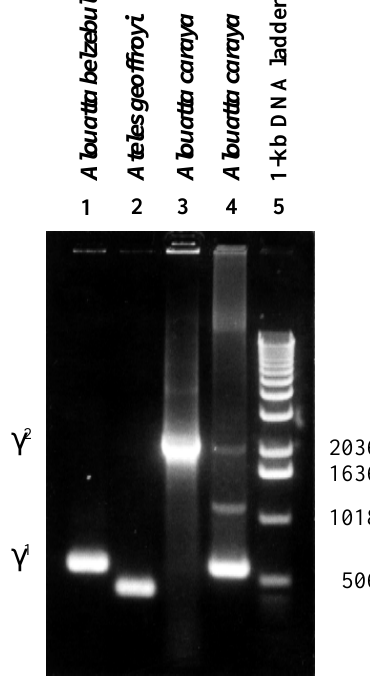
Figure 2 - PCR-amplified g gene DNA in atelids: 1 - g 1 fragment of the purified PCR product of Alouatta belzebul ; 2 - g 1 fragment of the purified PCR product of Ateles geoffroyi ; 3 - g 2 fragment of the purified PCR prod- uct of Alouatta caraya ; 4 - PCR products of the genomic DNA of Alouatta caraya ; 5 - 1-kb DNA